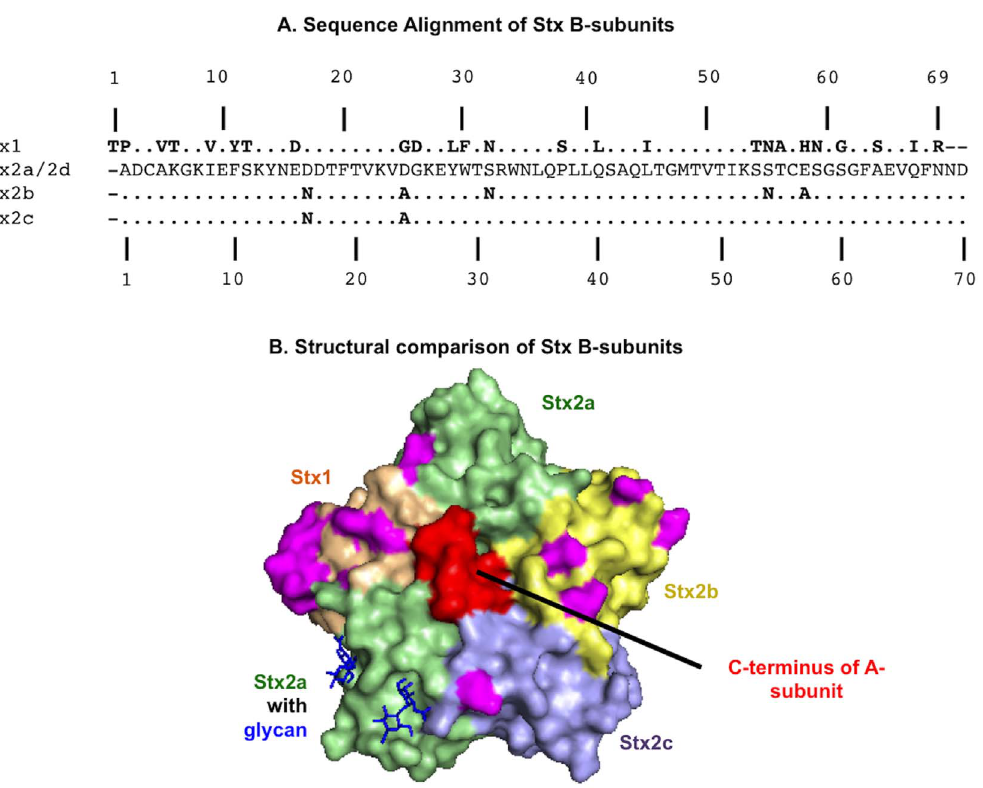
Figure 1. Comparison of B-subunits of Stx variants: (A) Amino acid sequence comparison. Amino acid sequences of Stx B-subunits were aligned using BLASTP (NCBI/BLAST). Periods indicate identity and dashes indicate absent amino acids. Amino acid differences with respect to Stx2a are denoted in bold. Numbering starts with the first amino acid of the mature peptide. (B) Structural comparison. The mutagenesis function of PYMOL was used to substitute amino acids of the Stx variants into the crystal structure of disaccharide bound Stx2a (PDB: 4M1U). The structures are oriented to display the receptor binding face of the B-subunits, with an individual subunit representing a different Stx variant. Color-coding is as follows: wheat, Stx1; green, Stx2a; yellow, Stx2b, blue, Stx2c, blue, bound disaccharide; red, A-tail of Stx2a; pink, amino acid polymorphisms with respect to Stx2a. Note that the Stx B-pentamer is made up of identical B-subunits.